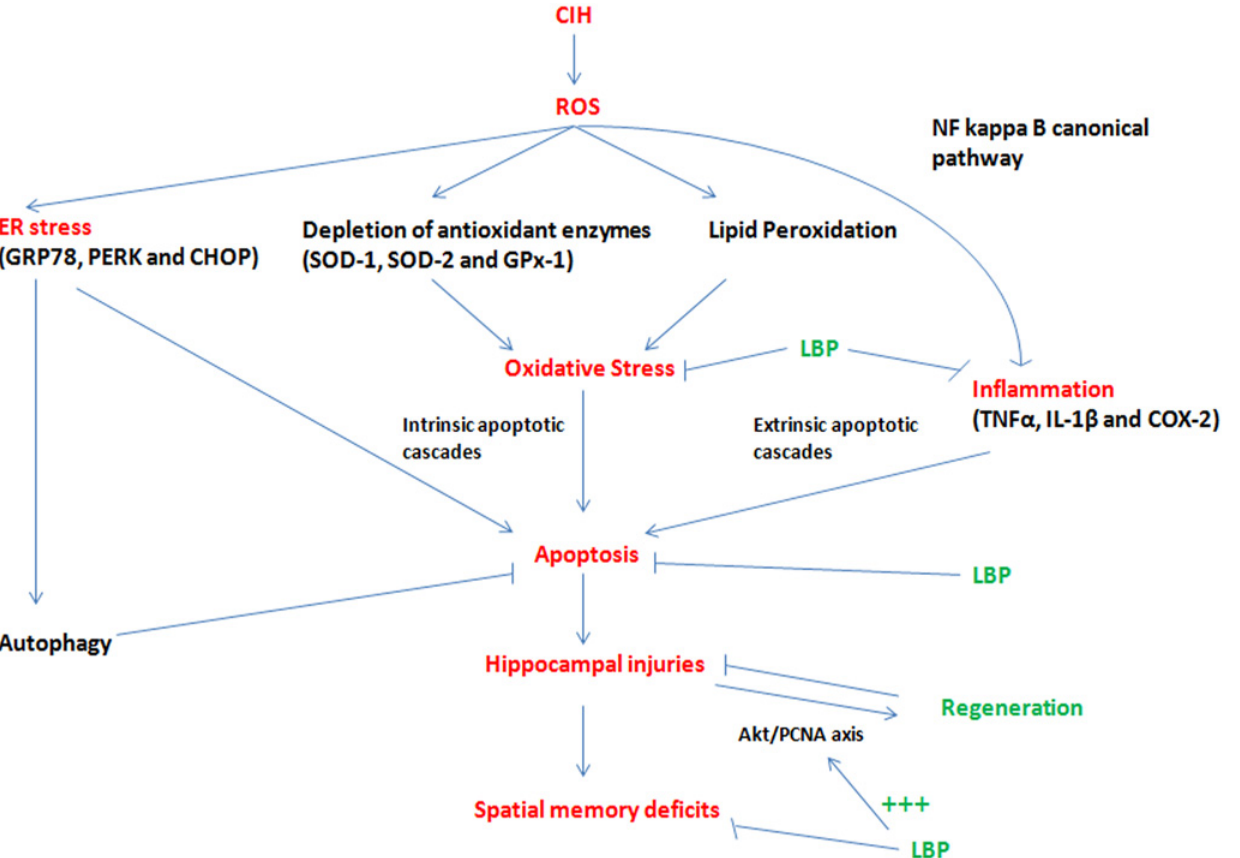
Fig 12. Summary of neuroprotection mechanisms of LBP against spatial memory deficits induced by CIH.